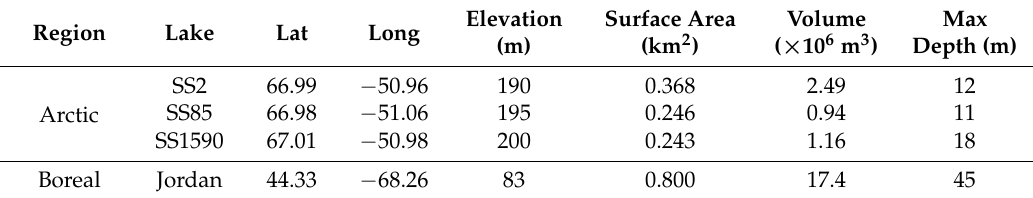
Table 2. Select characteristics of the four study